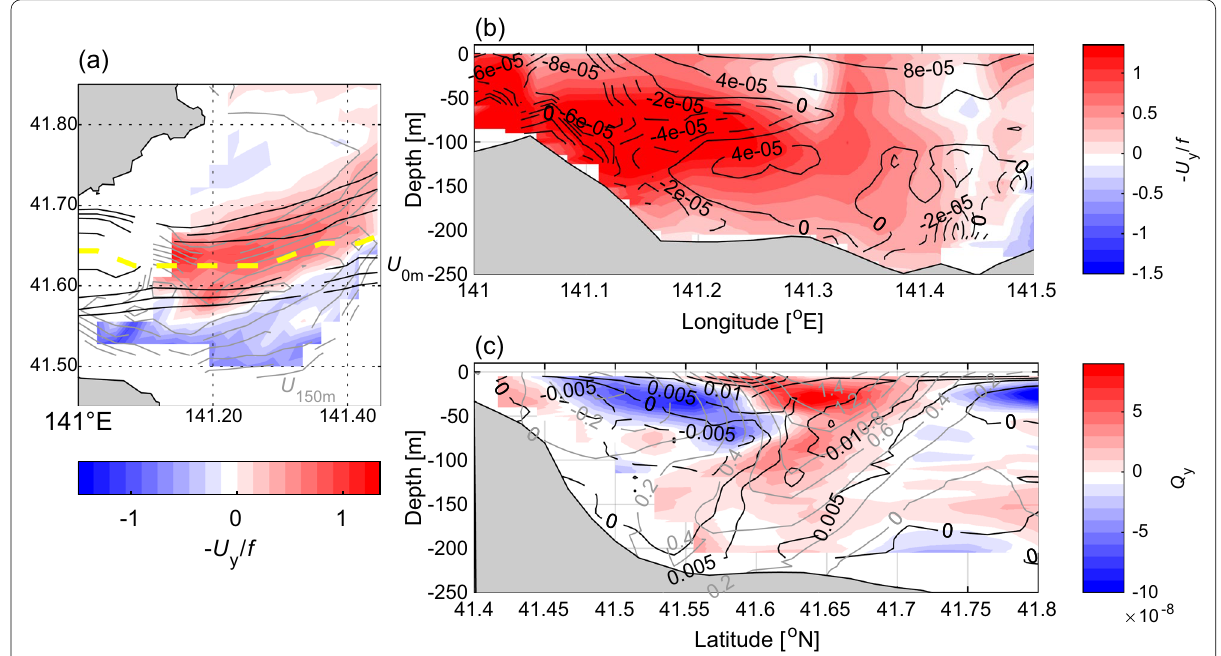
Fig. 11 a An example of the velocity at the upper layer (0 m: black contours, m s − 1 ) and lower layer (150 m: gray contours, m s − 1 ) estimated from the JCOPE-T DA data for July 26–27, 2019. The standardized relative vorticity term in Eq. 3 at 150 m is shown by color. The yellow line shows the axis of the Tsugaru Warm Current. b Vertical section of standardized relative vorticity along the axis (color) and divergence of the horizontal velocity (contour: s − 1 ). c Q y (differential of Q in the north–south direction) distribution in the cross front direction (141.3–141.4°E average) (color) with vertical shear (black contours: s − 1 ). Gray contours in c denote zonal velocity. Dashed contours in b and c denote negative values. Topography in c is the zonal mean for